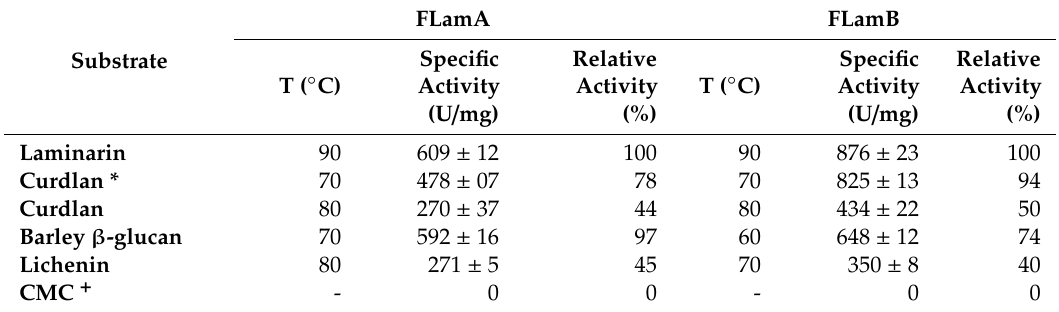
Figure 4. The temperature profiles of recombinant FLamA ( a ) and FLamB ( b ) depending on substrates laminarin, amorphous curdlan, unsolved curdlan, barley β -glucan, lichenin, and carboxymethyl cellulose (CMC). Table 1. Substrate specificity of FLamA and FLamB at the optimal temperatures for each